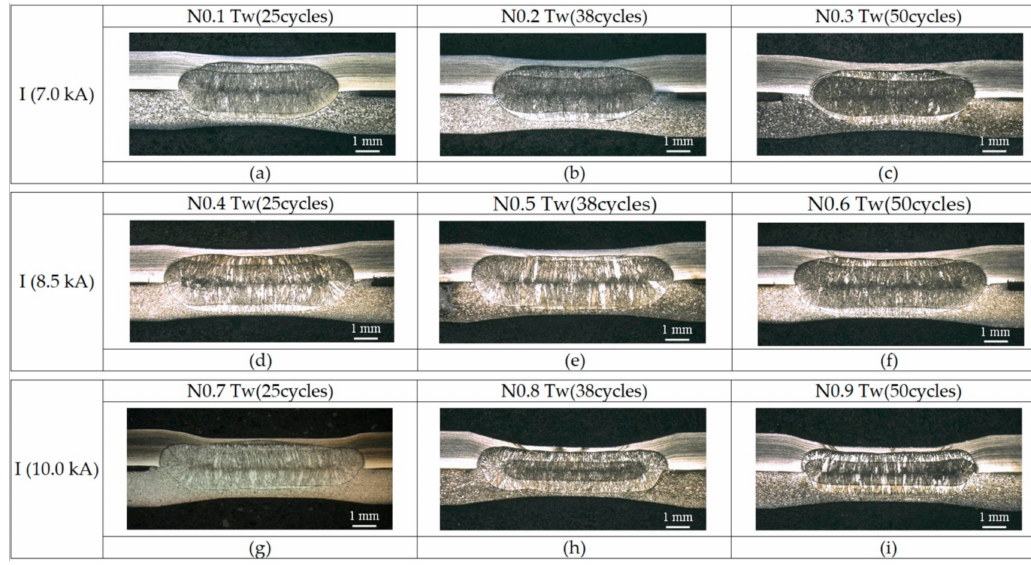
Figure 4. Macrostructure of RSW joints under welding parameters: weld current(kA) / welding time(cycles) ( a ) 7.0 / 25; ( b ) 7.0 / 38; ( c ) 7.0 / 50; ( d ) 8.5 / 25; ( e ) 8.5 / 38; ( f ) 8.5 / 50; ( g ) 10.0 / 25; ( h ) 10.0 / 38; ( i ) 10.0 /